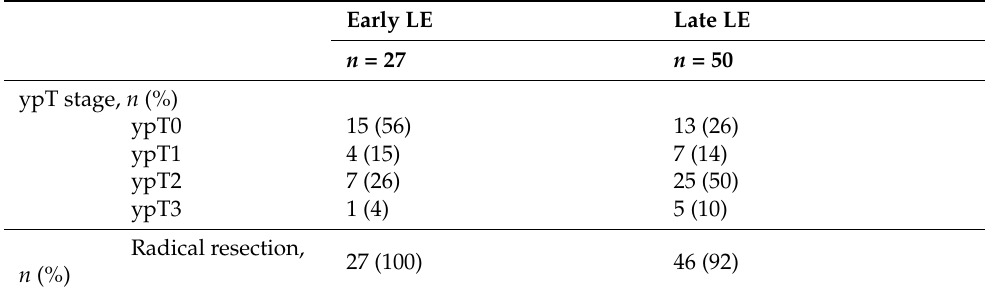
Table 2. Histological results after early (<6 months after last radiation) and late ( ≥ 6 months) local